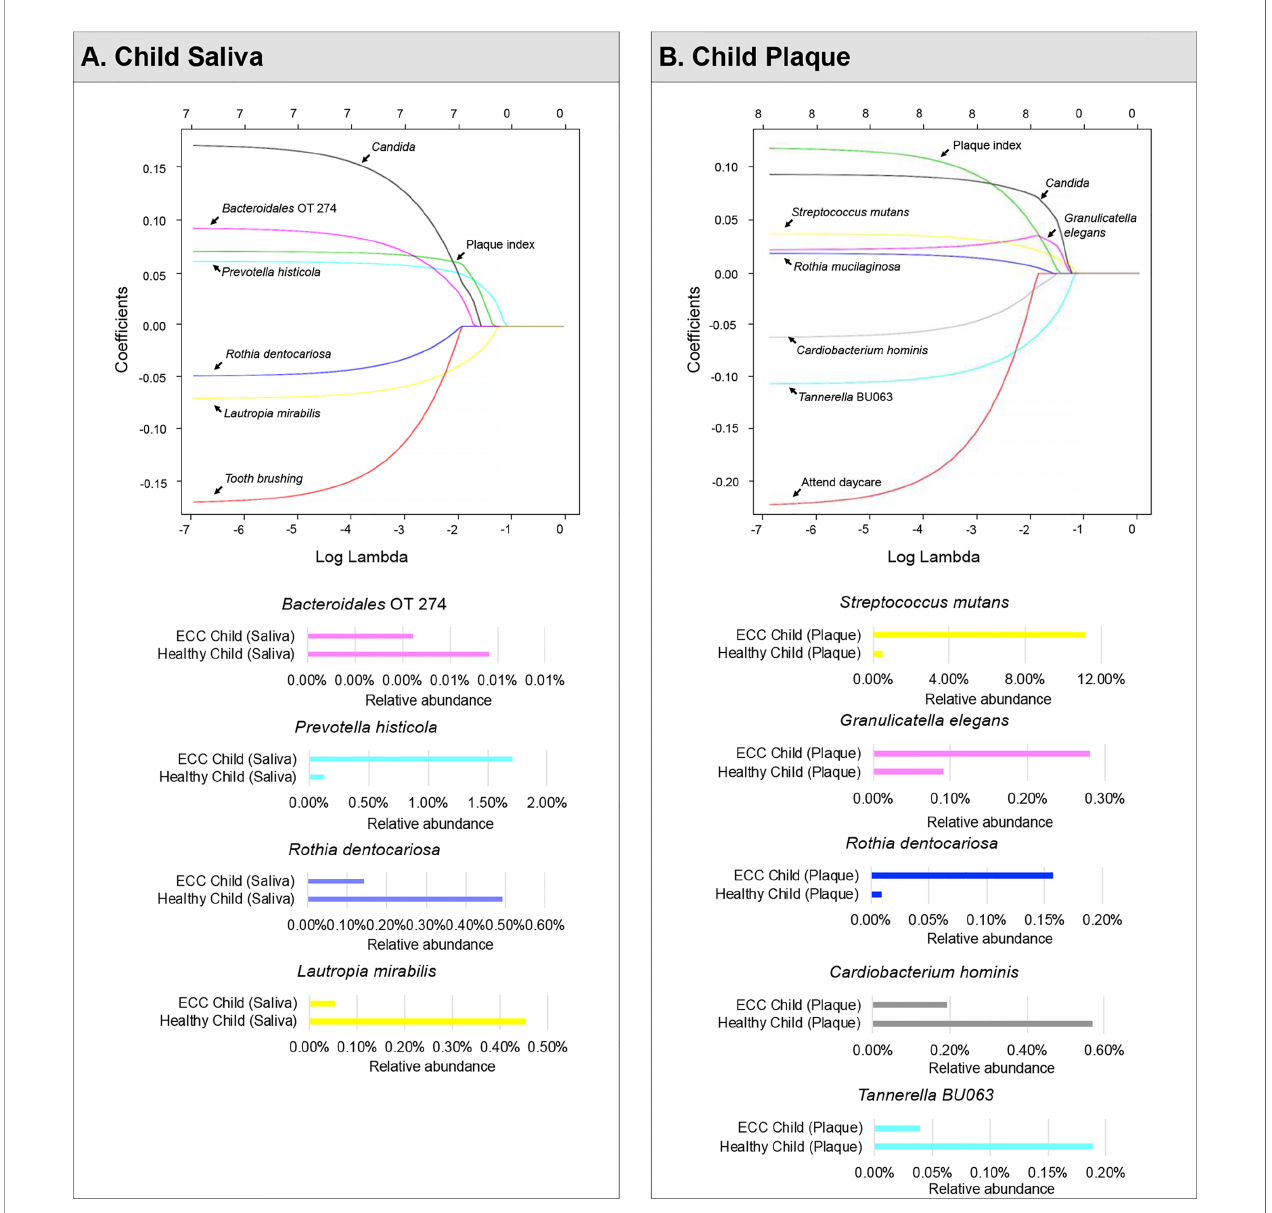
FIGURE 2 | Identi fi ed factors associated with child ’ s caries risk using machine Learning model. LASSO-penalized logistic regression modeling was used for caries predictor selection for children ’ s saliva and plaque samples. Speci fi cally, seven variables for models using salivary microorganisms (A) and eight variables for models using plaque microorganisms (B) were identi fi ed as predictive factors for dental caries in preschool children. The LASSO solution path above shows how the model is built sequentially by adding one variable at a time to the active